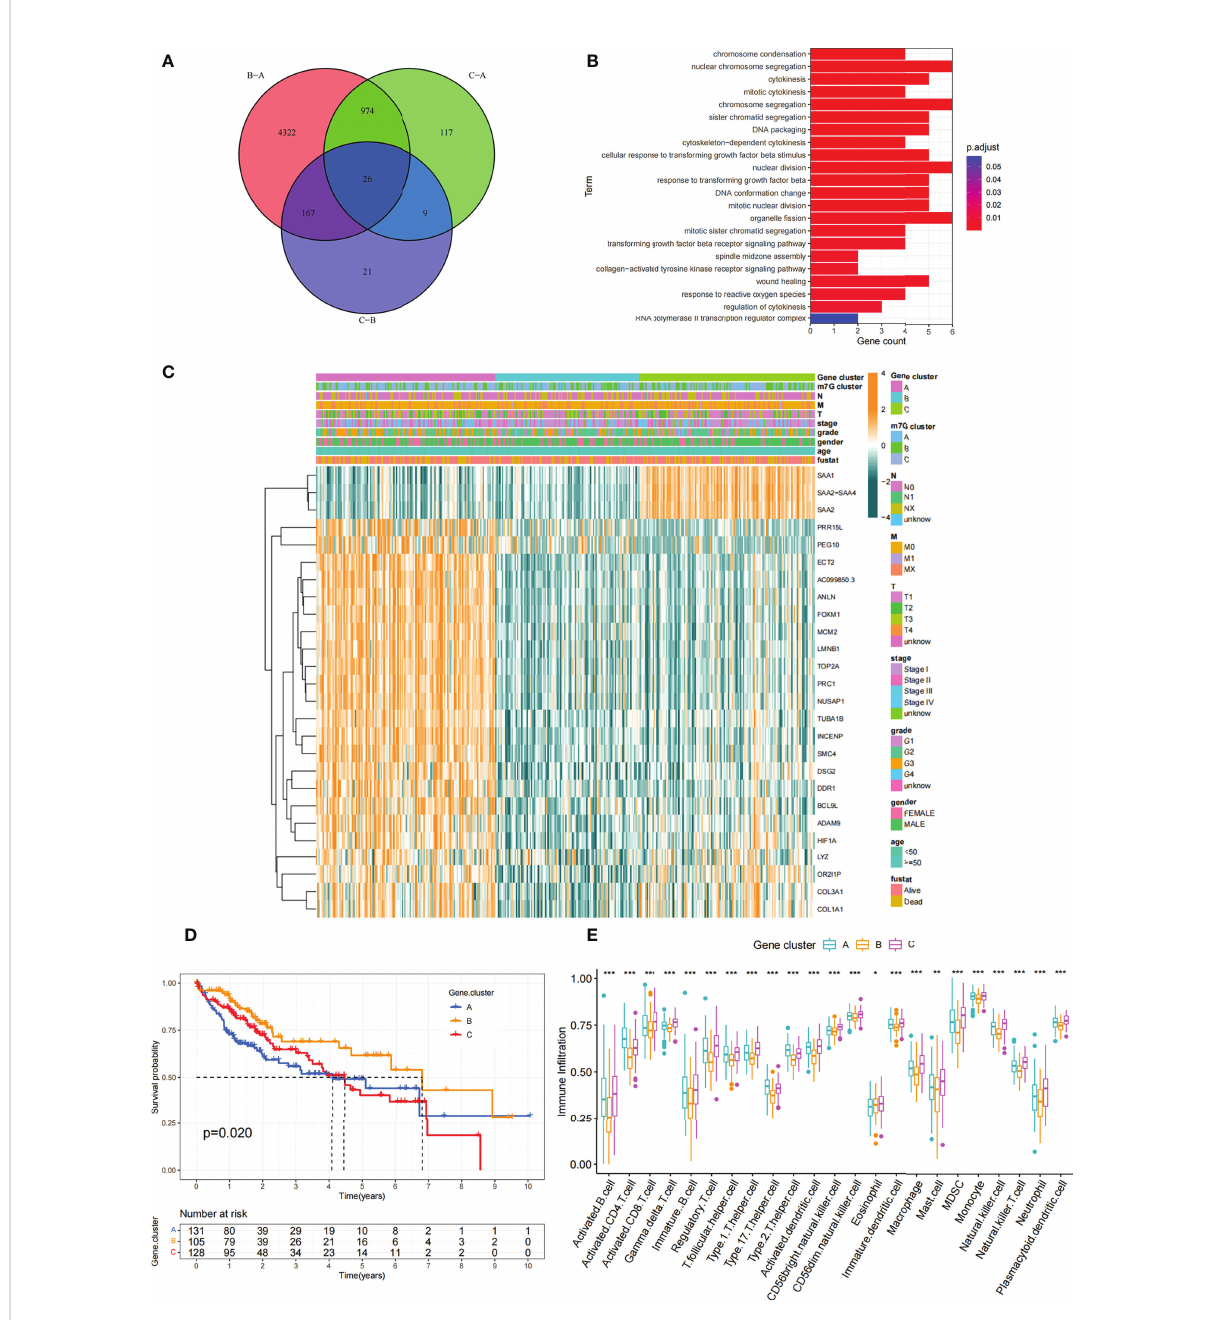
FIGURE 6 Construction of differential expression of m 7 G gene signatures and functional annotation. (A) Venn diagram showing 26 m 7 G-related DEGs between three m 7 G clusters. (B) Functional annotation of m 7 G-related genes using GO enrichment analysis. The color depth of the bars represent the amount of gene enrichment. (C) Unsupervised clustering of DEGs associated with overlapping m 7 G phenotypes classi fi ed patients into different gene clusters, which were called m 7 G gene cluster A, B and (C) The m 7 G gene cluster, m 7 G cluster, TMN stage, gender, and age were used as patient annotations. (D) Survival curves for m 7 G phenotype-associated genes were plotted. (P=0. 02). (E) Abundance of individual TME-in fi ltrated cells in the three m 7 G gene clusters. Asterisks represent statistical p-values (*P < 0. 05; **P < 0. 01; ***P < 0.